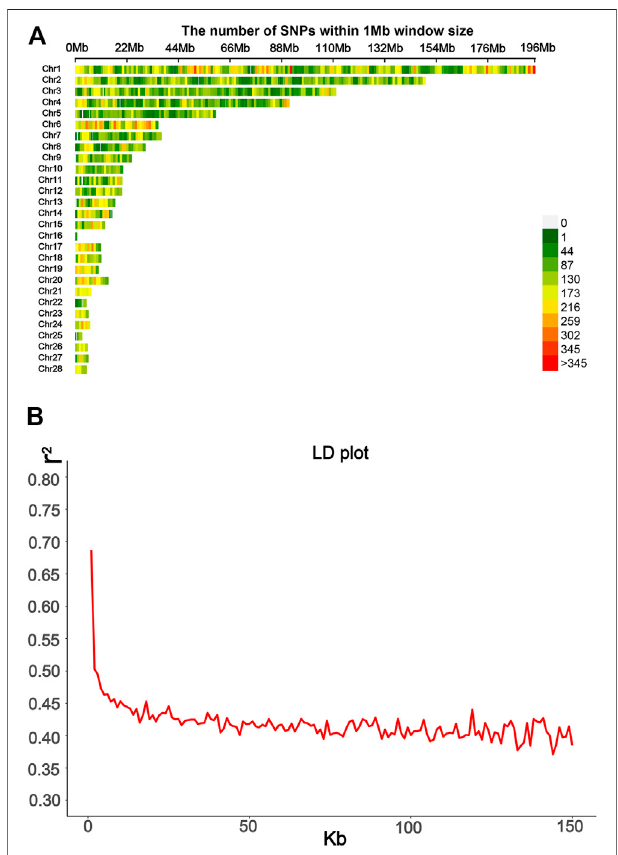
FIGURE 2 | Information from SLAF-seq genotyping was used in this study. (A) SNPs ’ density distribution on 28 autosomes; the SNP density based on a 1 Mbp window was estimated. (B) Average distance between SNPs was used to calculate the LD decay plot.